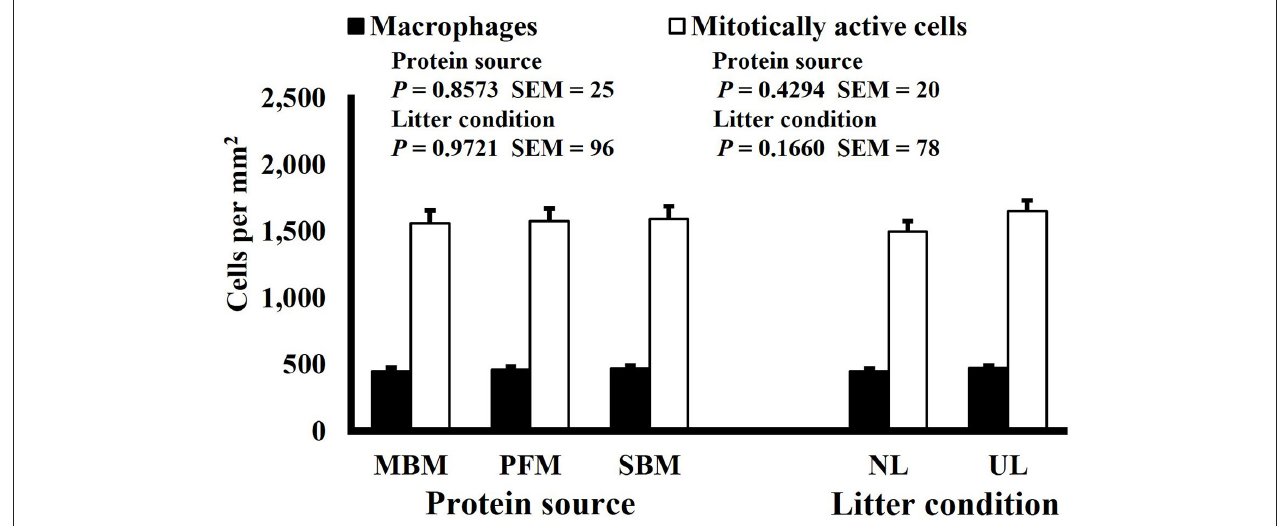
FIGURE 8 | Effect of dietary protein source and litter condition on macrophage (KUL01 + ) and mitotically active (BrdU + ) cell densities (cells per mm 2 ) in the ileum of 11-d-old broilers ( n = 36 per sampling d, 6 birds per treatment). MBM, meat and bone meal; PFM, 50% poultry by-product and 50% feather meal blend; SBM, soybean meal; NL, new litter, UL, used litter.